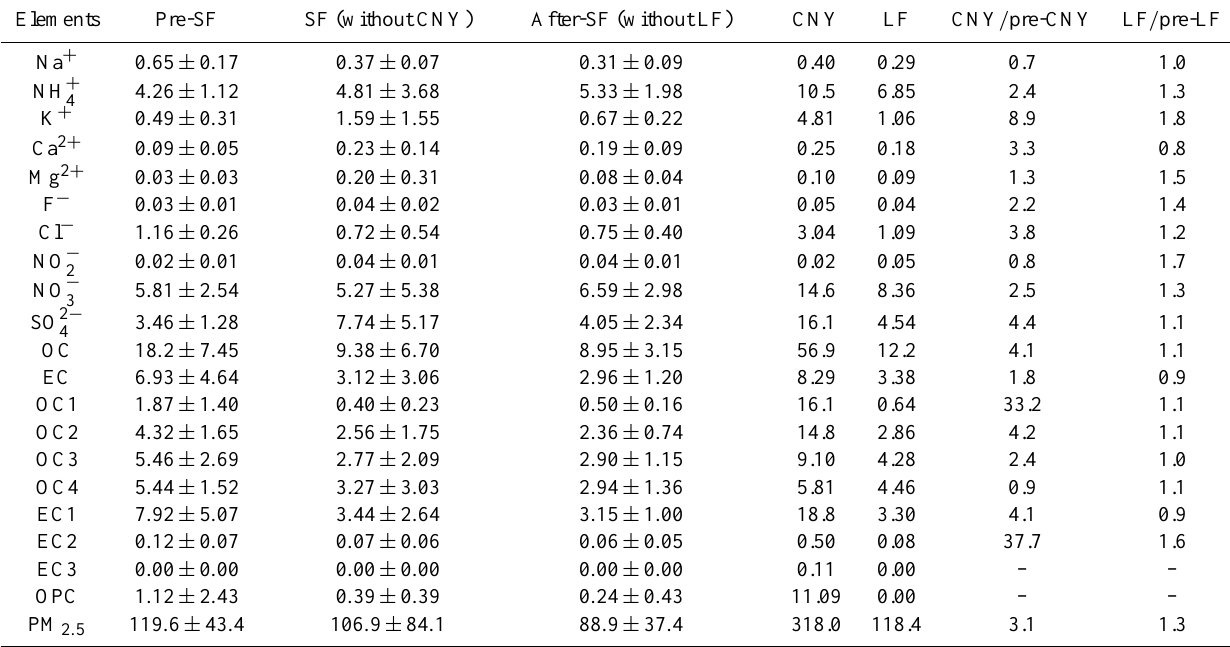
Table 2. Mass concentrations of ions and carbonaceous species in PM 2 . 5 before, during and after the 2014 Chinese Spring Festival in Nanjing (µgm − 3